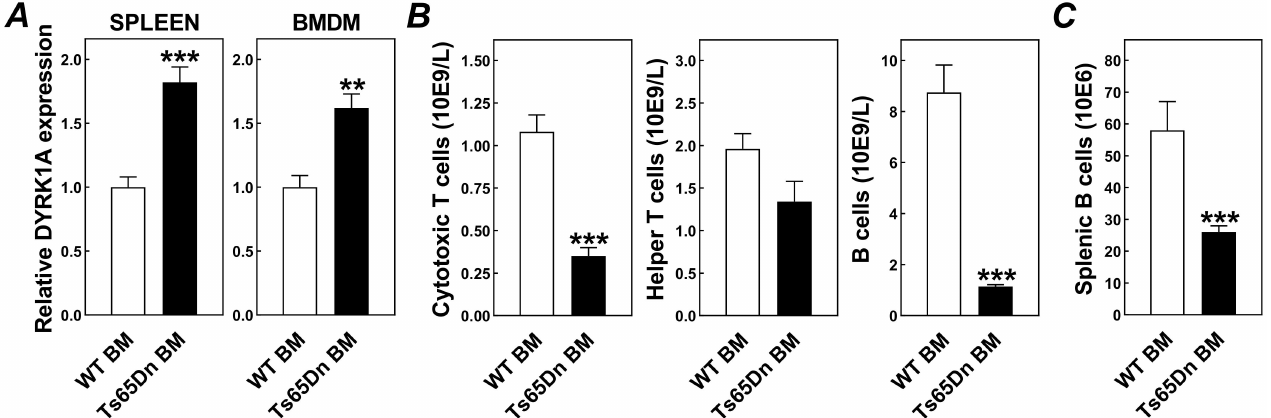
Figure 1. Successful induction of bone marrow trisomy is associated with lymphocytopenia. ( A ) Relative mRNA expression levels of the trisomic gene DYRK1A in spleens and bone marrow-derived macrophages (BMDM) and amounts of different lymphocyte subsets in blood specimens ( B ) and spleens ( C ) from Western-type diet-fed LDL receptor knockout mice that have received wild-type bone marrow (WT BM) or Ts65Dn bone marrow (Ts65Dn BM). Data represent means + SEM of respectively 10/12 mice (left figure in panel A ) or 6 mice (all other figures) per group. ** p < 0.01, *** p < 0.001 versus WT